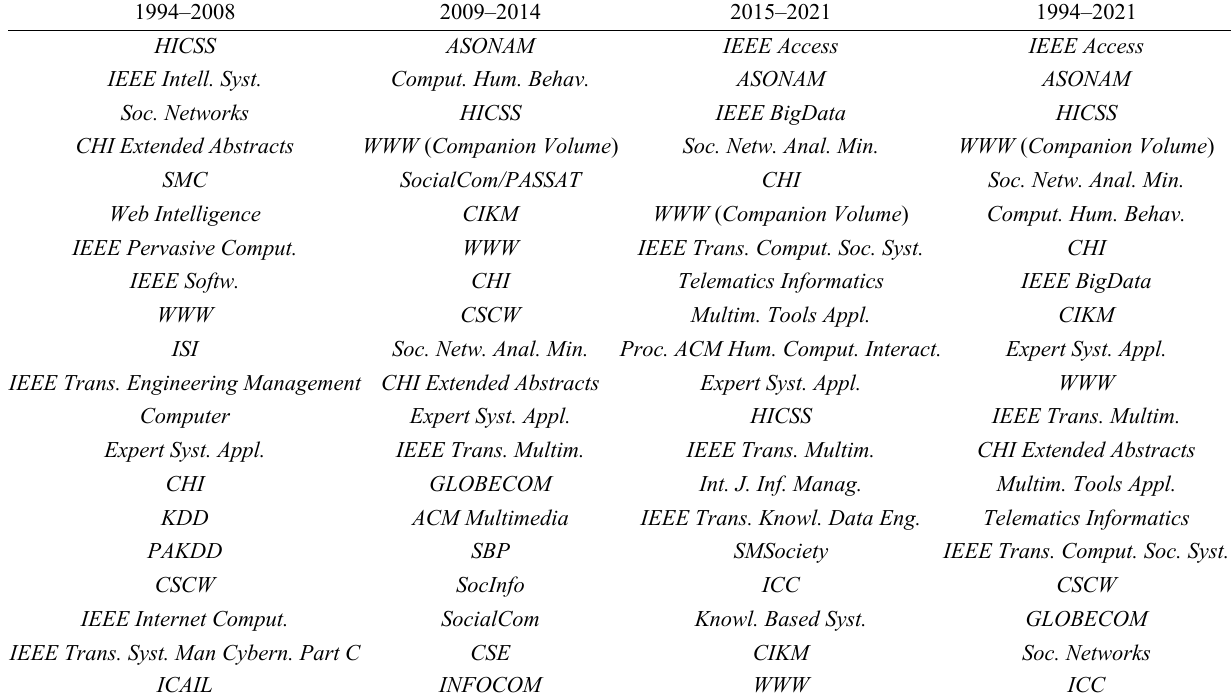
Table 4 Top 20 publication venues in different time